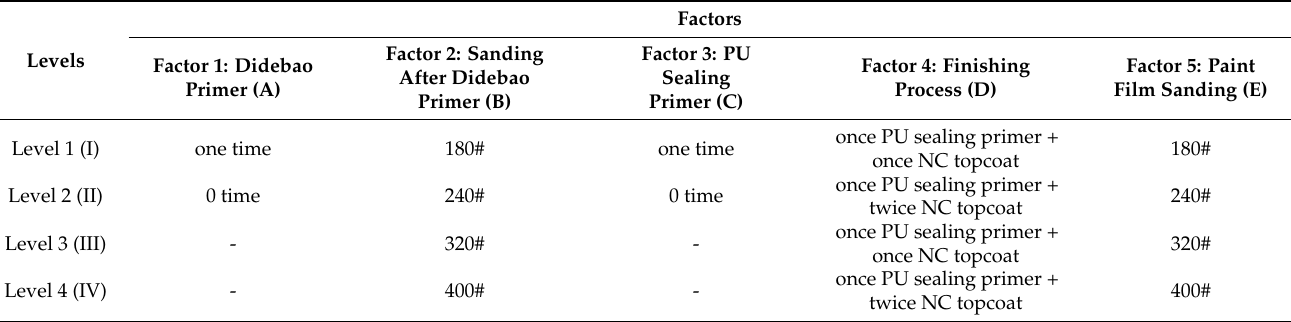
Table 1. Non-transparent coating factor level.